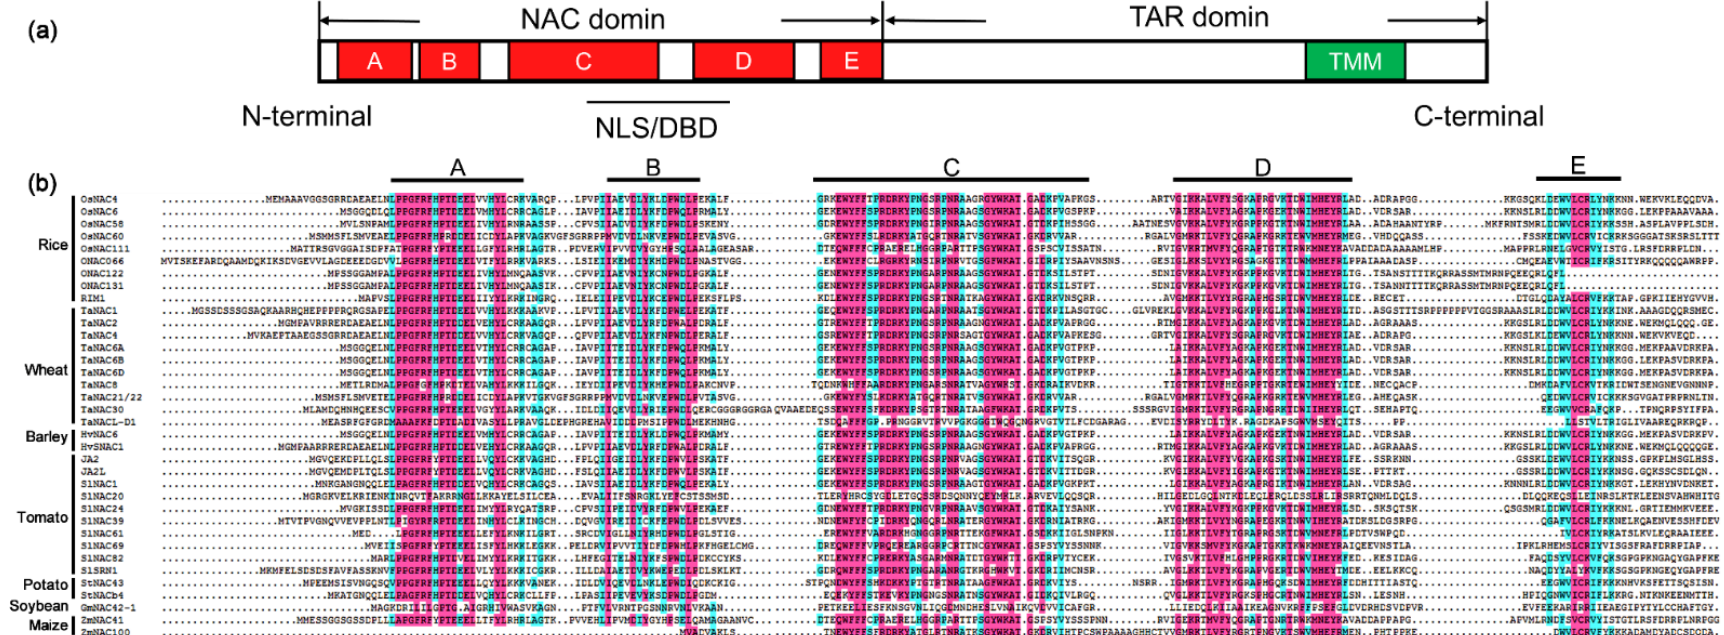
Figure 2. Diagram of the NAC proteins structure and sequence alignment of NAC domains. ( a ) Schematic representation showing a typical NAC protein with a highly conserved NAC domain at the N-terminal which is further divided into five conserved subdomains ( A – E ). The NAC domain contains nuclear localization signals (NLSs) and DNA-binding domain (DBD). The C-terminal region is a relatively divergent transcriptional activation region (TAR). In some cases, the C-terminal may have a transmembrane motif (TMM). ( b ) Sequence alignment of NAC domains for most of crops cited in the review. Subdomains A to E are shown by horizontal lines above the sequence. The red color represents amino acids with more than 75% common consensus sequences, and the cyan color represents amino acids with more than 50% common consensus sequences.